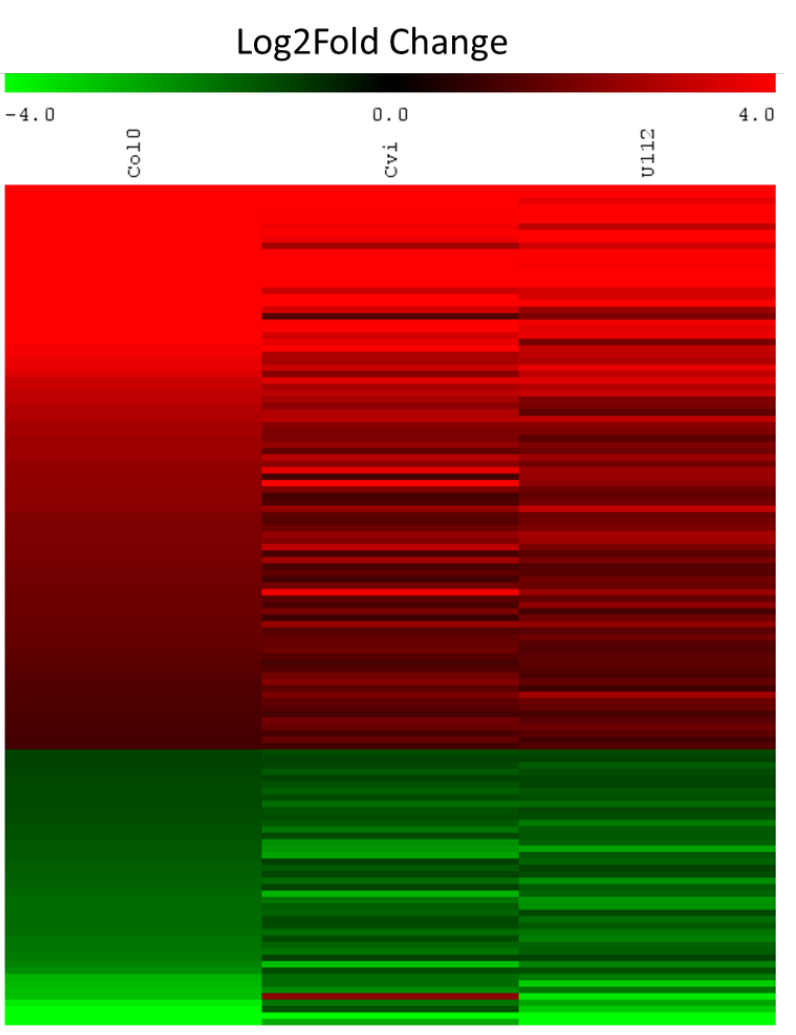
Figure 8. Heat map shows the expression pattern of the 131 common DEGs of Col-0, Cvi-0, and U112-3. The expression values are shown as log2 fold change.